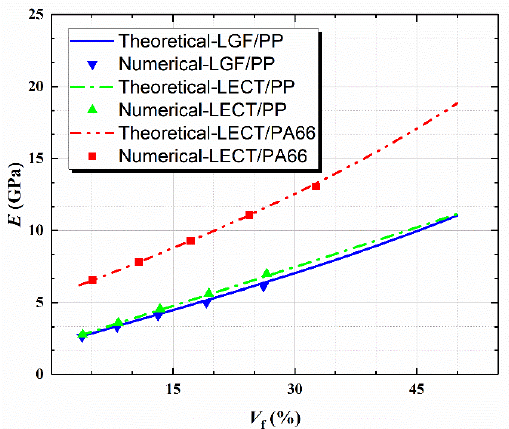
Figure 3. Theoretical and numerical tensile elastic modulus of LFT composite.